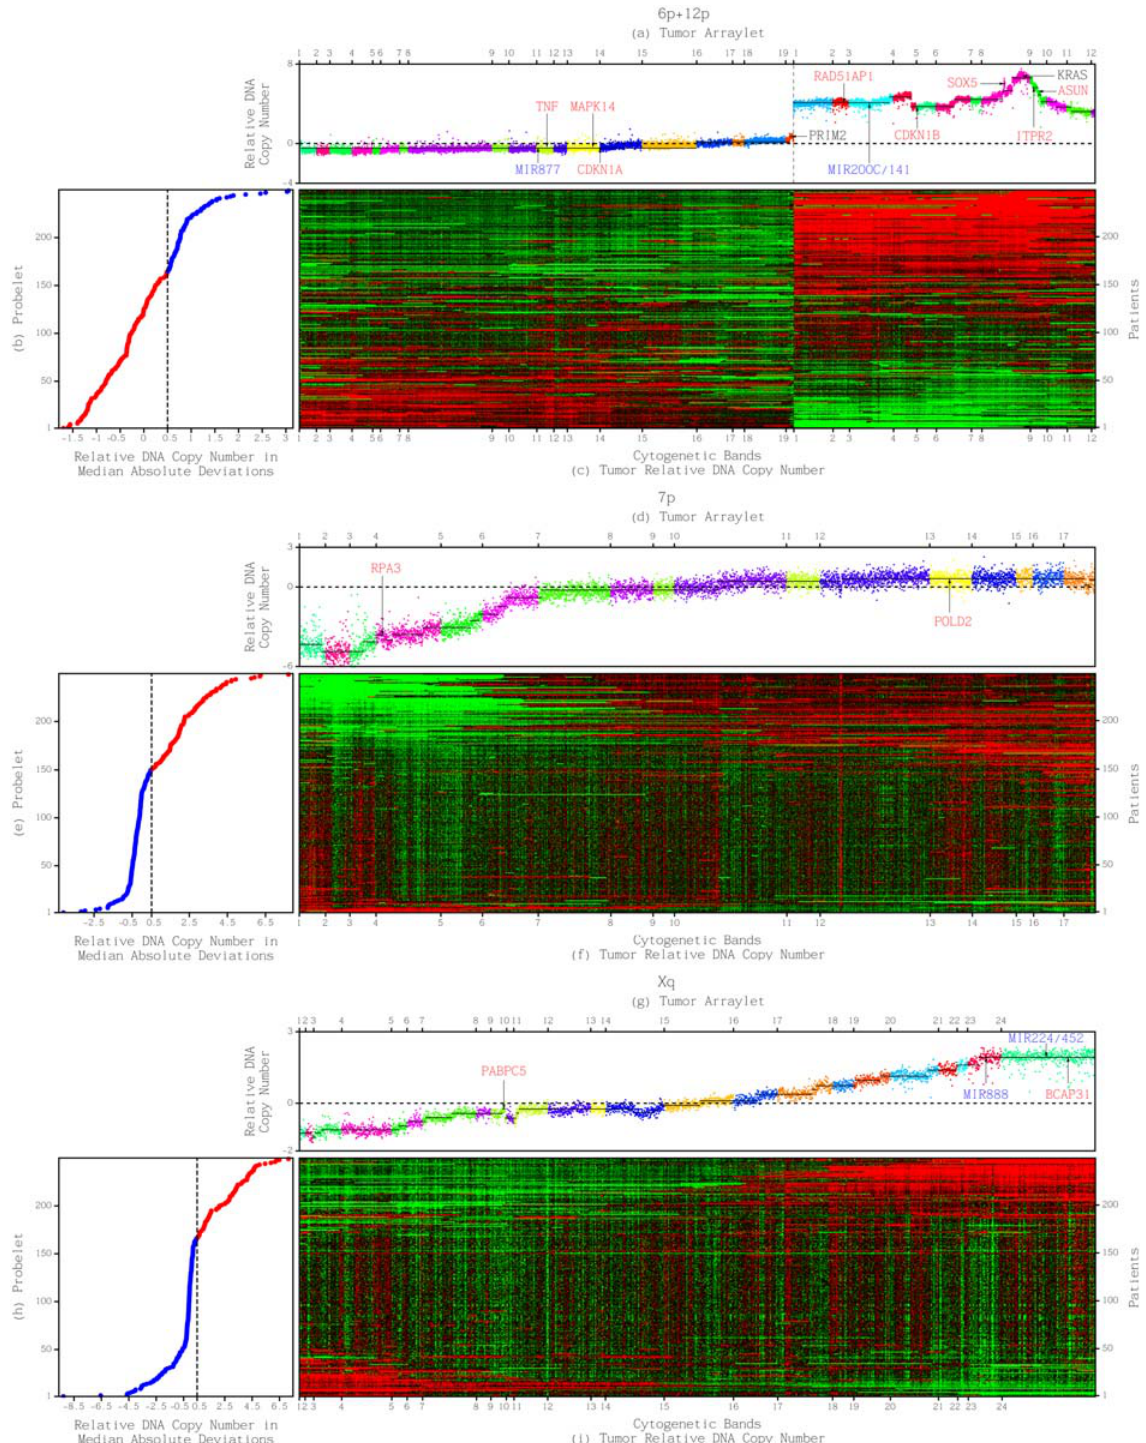
Fig 2. Tumor-exclusive and platform-consistent DNA copy-number alterations (CNAs) correlated with ovarian serous cystadenocarcinoma (OV) patients ’ survival. ( a ) Plot of the first 6p+12p tumor arraylet describes a pattern of tumor-exclusive and platform-consistent co-occurring CNAs across the combination of the two chromosome arms 6p+12p. The probes are ordered, and their copy numbers are colored according to each probe ’ s chromosomal band location. Segments (black lines) amplified and deleted include most known OV-associated CNAs that map to 6p+12p (black), including an amplification of KRAS and a deletion of PRIM2 . CNAs previously unrecognized in OV (red) include a deletion of the p38-encoding MAPK14 , and p21-encoding CDKN1A ,